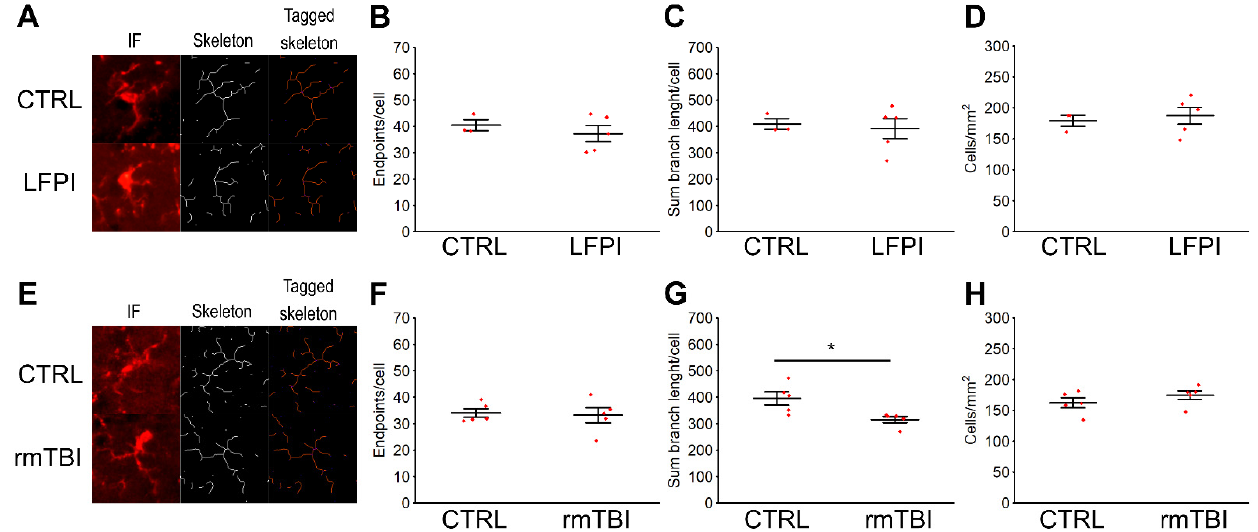
Figure 5. Effects of single moderate lateral fluid percussion injury (LFPI) or repetitive mild traumatic brain injury (rmTBI) on the microglial activation pattern in the hippocampal dentate gyrus: Analysis of microglial morphology and the number of cells was done on hippocampal sections that were stained by immunofluorescence (IF) with the anti-Iba1 antibody. Images are representative of 3–5 mice per group. The cells were converted to their skeleton form ( A , E ) followed by the analysis of the number of branches (endpoints) per cell ( B , F ) and sum branch (process) length per cell ( C , G ). Results show that the microglia in the dentate gyrus of the hippocampus of mice sacrificed at 14 d following the last mild trauma in the rmTBI experiment have significantly reduced sum branch length compared with control mice, implying a more amoeboid reactive morphology. In both LFPI and rmTBI experiments, the total number of microglial cells per mm2 in the investigated brain region did not differ from the data from the respective control groups ( D , H ). Each dot represents data from an individual mouse. Data are pooled from at least six sections from 3–5 mice per group. * p < 0.05 ; significantly different from the related control group.